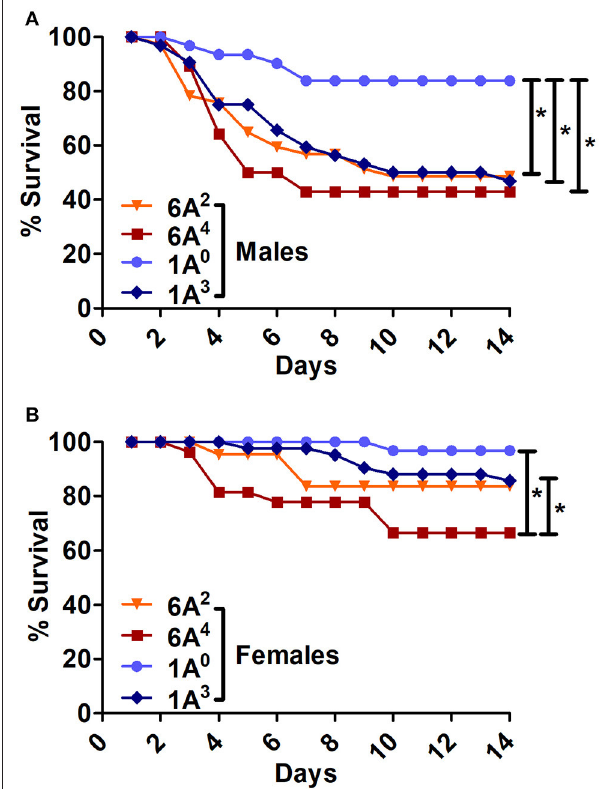
FIGURE 3 | Comparison of survival as a function of SP-A gene-specific variant after K. pneumoniae infection . (A) Depicts differences in survival between male and female mice of SP-A1 (6A 2 , 6A 4 ) and (B) depicts differences of SP-A2 (1A 0 , 1A 3 ) variants. Mouse survival was monitored for 14 days after infection. Significant differences for survival are indicated * p < 0.05. The number of mice used for each group is shown in Figure 2 .